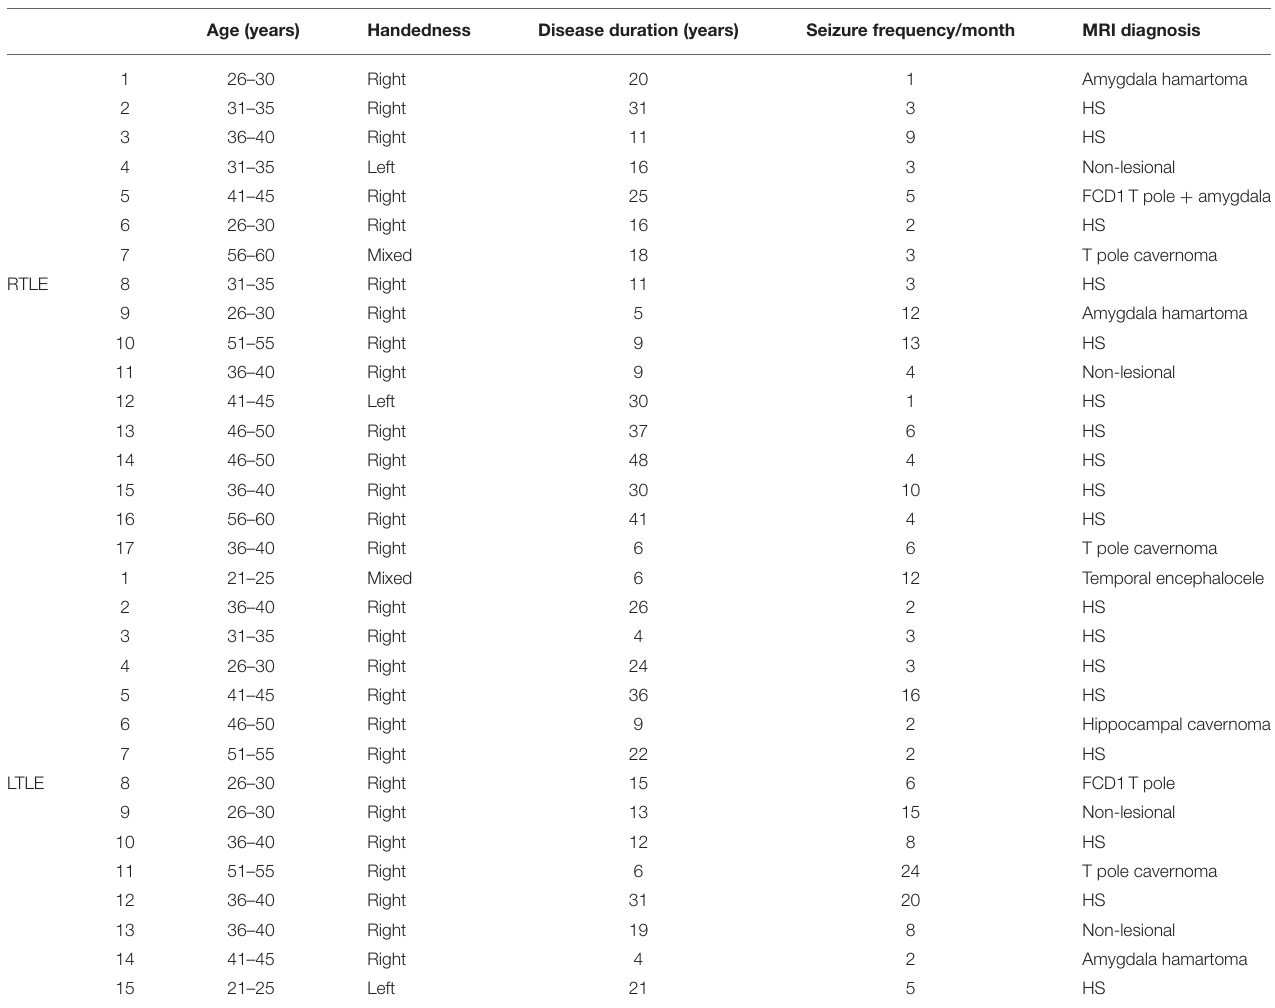
TABLE 1 | Characteristics of patient